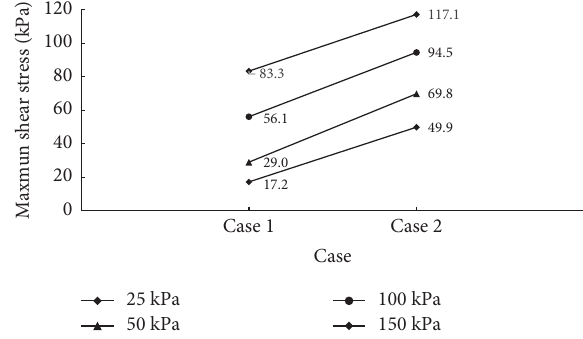
Figure 8: Coal gangue particle gradation curve before and after the test.